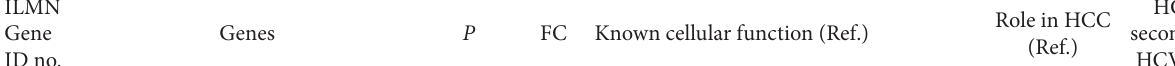
Table 3: Highly significant upregulated genes in HCC-R tumors with known and unknown functions (references are based on PUBMED